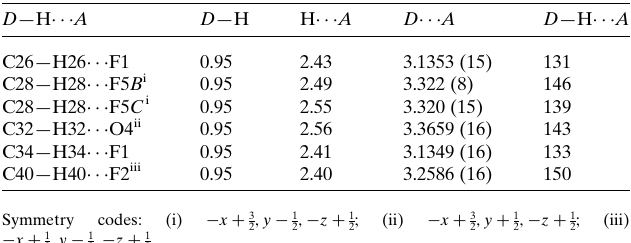
Table 1 Hydrogen-bond geometry (A˚ , (cid:5) ).